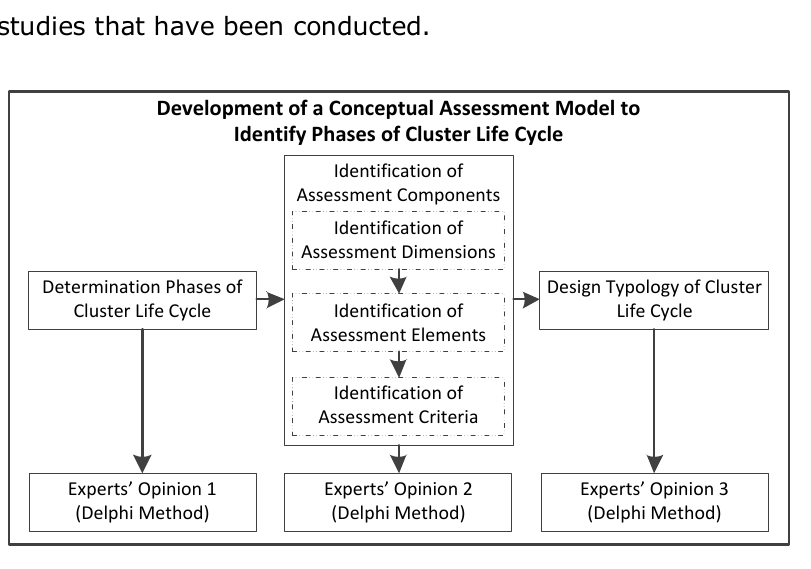
Figure 3. Research methodology to develop a conceptual assessment